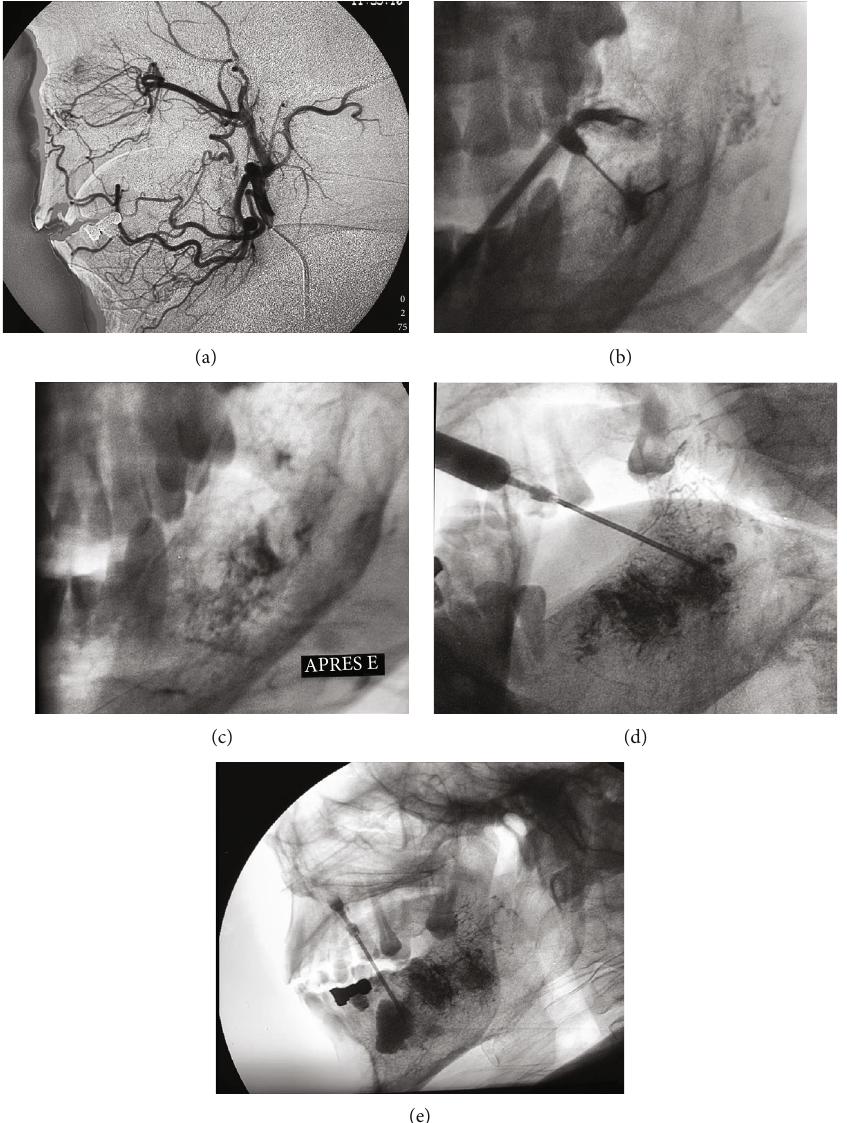
Figure 3: (a) Lateral digital subtraction angiography image displayed the inferior alveolar and lingual arteries. (b) Direct intraosseous histoacryl injection. (c) Image after ending of histoacryl injection. Intraosseous injection of CMW3 ™ (d) in the posterior part of the lesion and (e) in the anterior